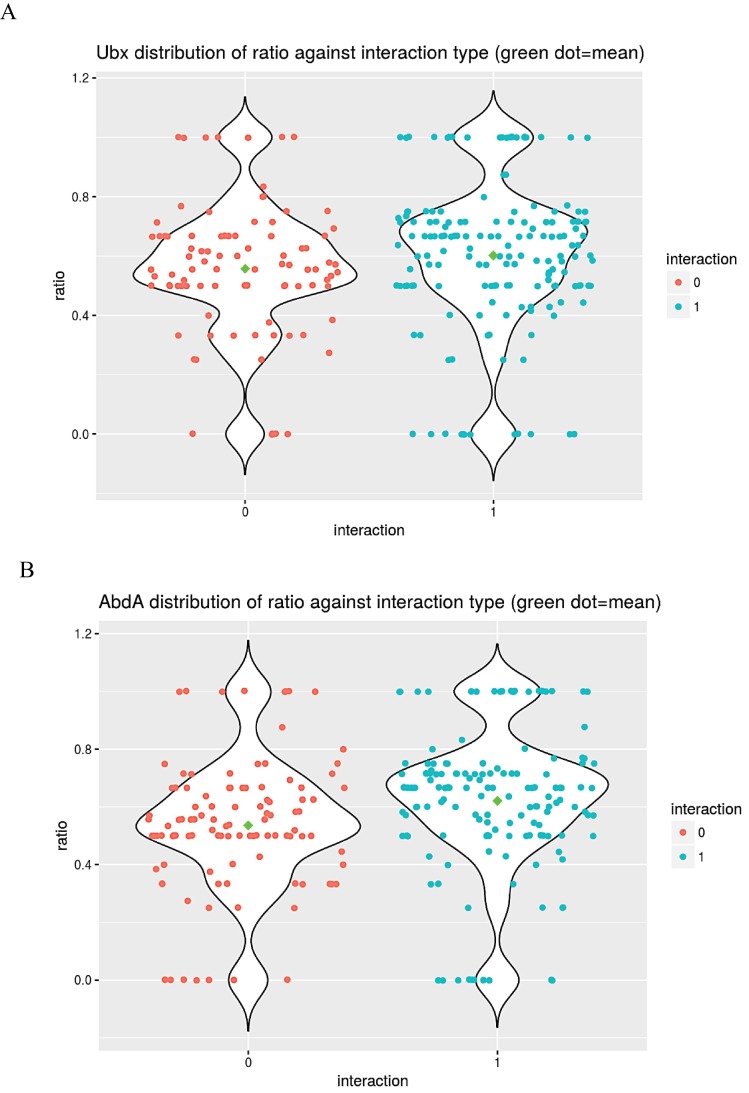
Analysis of the co-expression and interaction status of Ubx (A) or AbdA (B) and the positive ORFs.The distributions of the values taken by the ratio between the number of tissues in which the TF and Ubx or AbdA are co-expressed and the total number of tissues composing the TF expression domain during embryogenesis (among the 25 analysed developmental contexts) with regard to their interaction status (red and blue dots indicate negative (0) and positive (1) interaction status between the TFs and Hox proteins, respectively). Green circles show the means of the distributions.